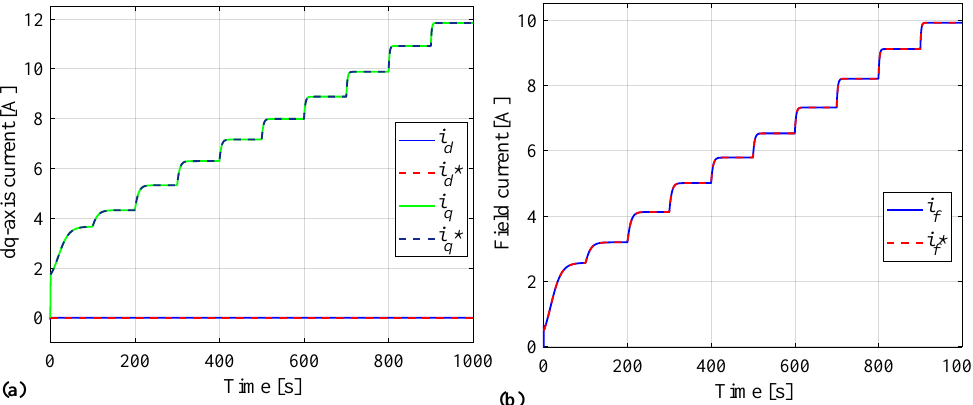
Figure 13. ( a ) dq -axis and ( b ) field current responses for wind speed variation versus